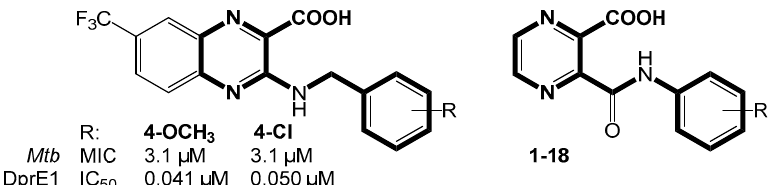
Figure 2. Comparison of the basic scaffold of previously prepared DprE1 inhibitors and structures presented in this paper.